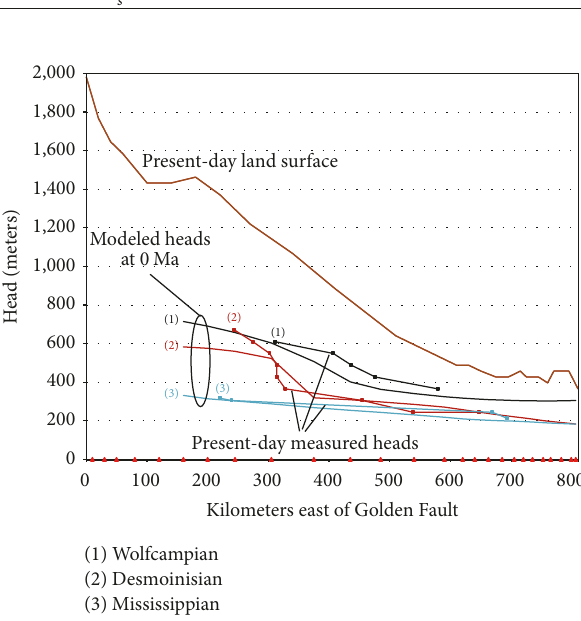
Figure 31: Results from the 0 Ma model, representing the 2- million-year period from 2 to 0 Ma and present-day head values. Model curves (1) , (2) , and (3) (Wolfcampian, Desmoinesian, and Mississippian, resp.) approximate the present-day data curves. Red triangles at centroids of the grid columns mark the initial zero heads at 70 Ma.